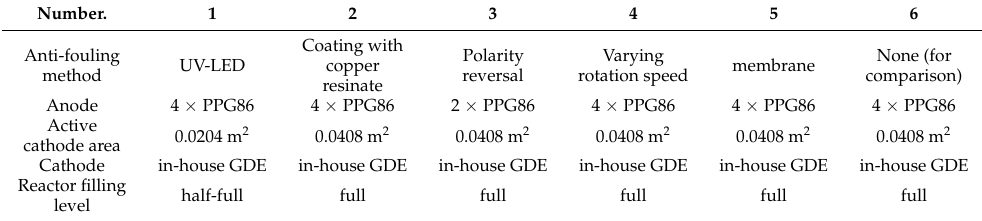
Table 2. Configuration of the investigated